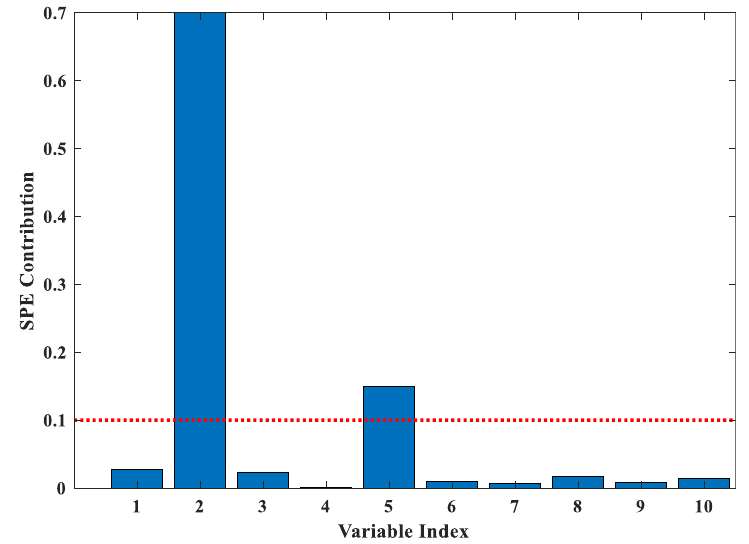
Figure 12. SPE contribution plot for fault diagnosis of F2 based on NMI-WMPCA.